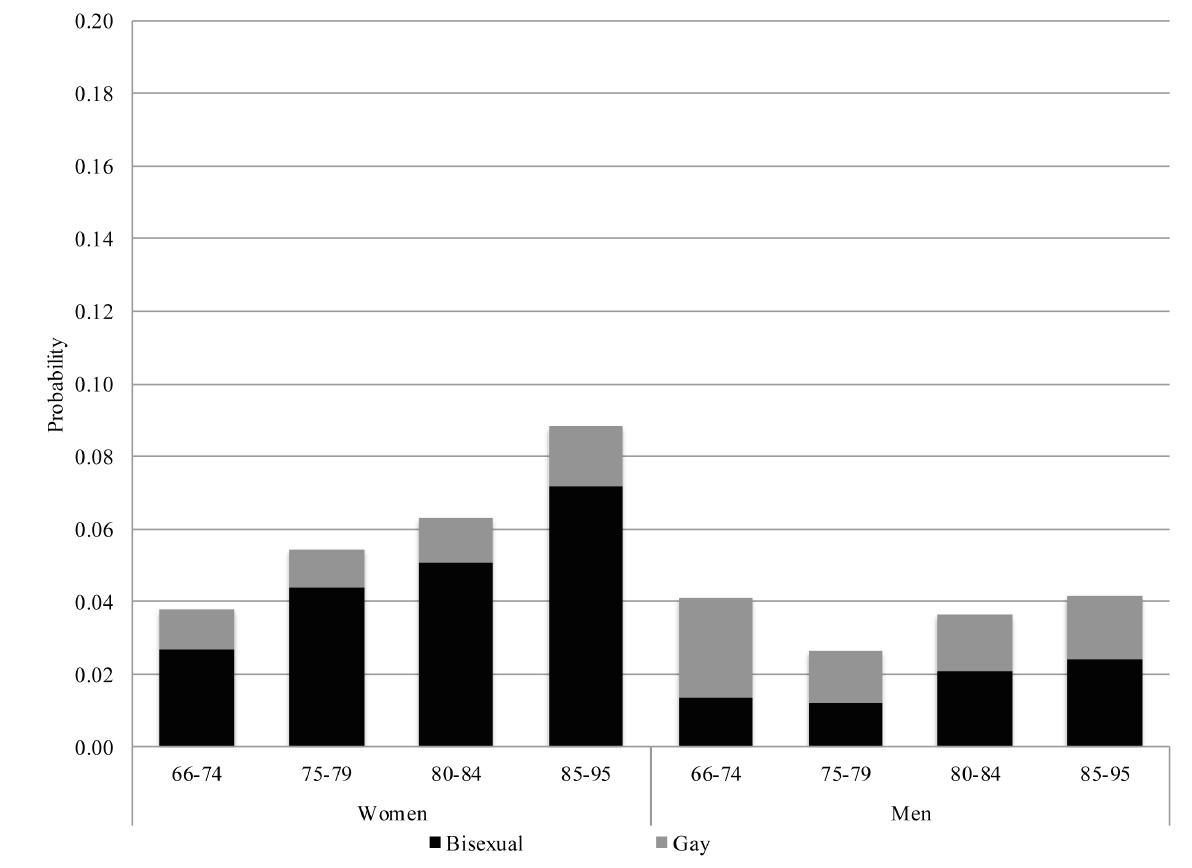
Figure 2: Women’s and men’s predicted probability of identifying as bisexual or gay, by birth